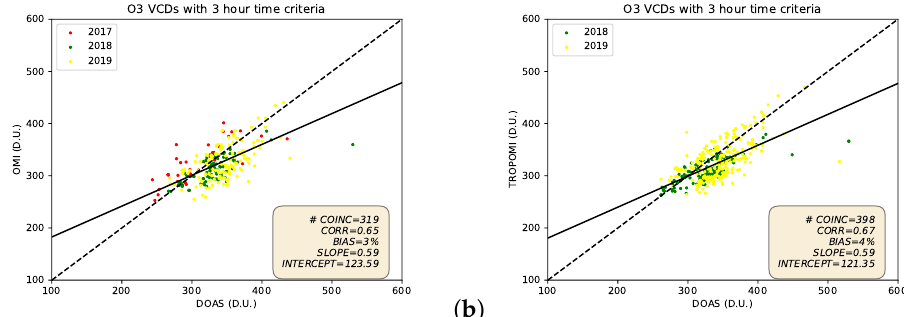
Figure 16. Scatterplot of O 3 VCDs measured by GASCOD/NG4 versus OMI ( a ) and TROPOMI ( b ). DOAS data were averaged within the 3-h time bin and are compared with the mean satellite VCDs in the same time bin and within a radius of 20 km from the ECO